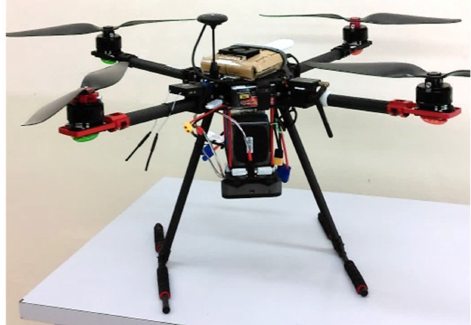
Figure 3. The proposed